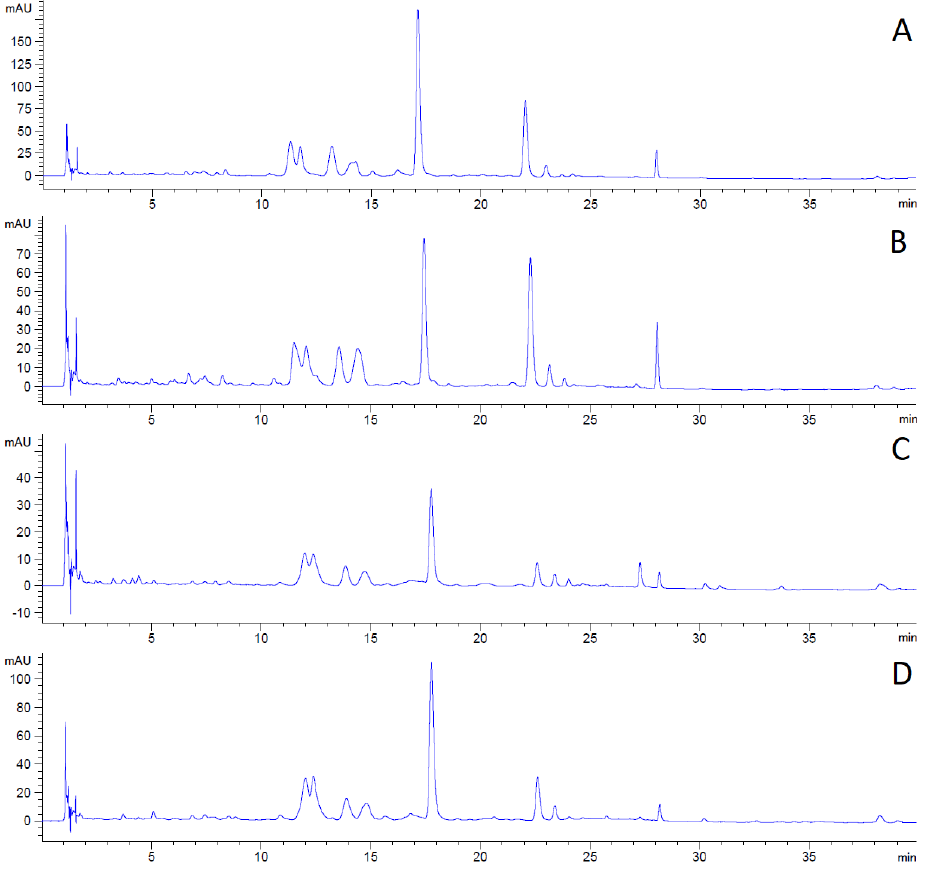
Figure 2. LC chromatograms of the hemp concentrates, measured at 270 nm. ( A )—before flowering 2019, ( B )—flowering 2019, ( C )—after flowering 2019, ( D )—after flowering 2018.